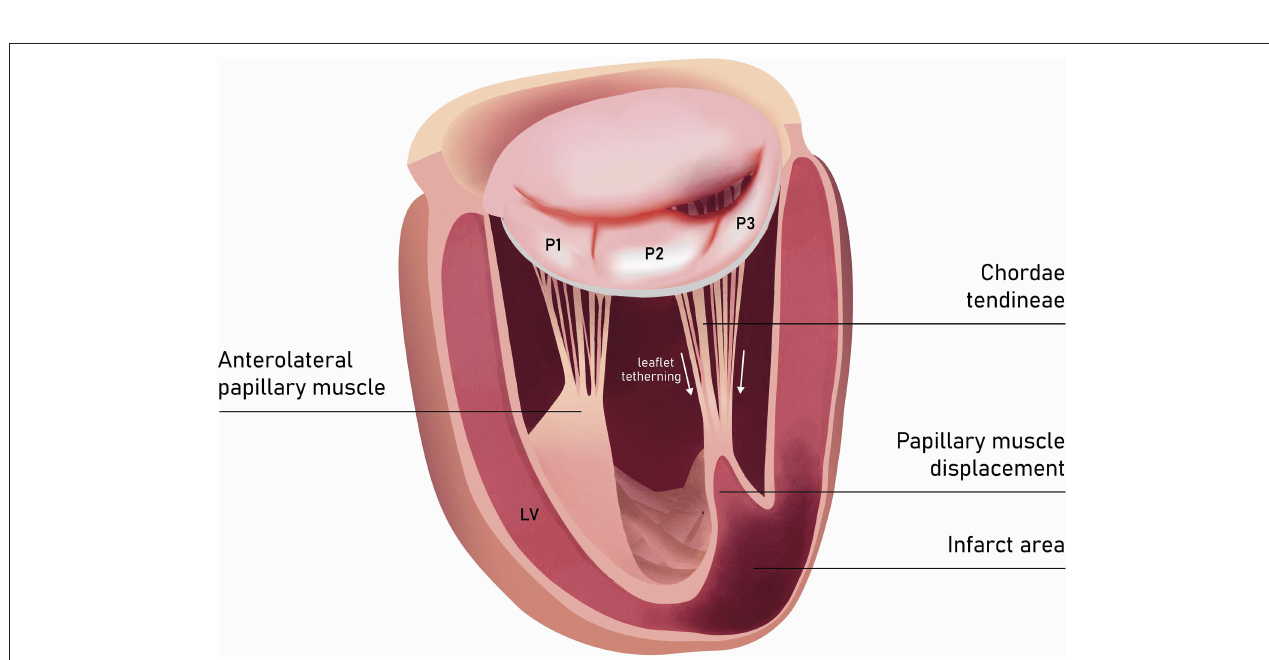
FIGURE 7 | Left ventricle and mitral valve—side view (LVOT was not depicted). The restricted leaflet motion and tethering in the course of posterior papillary muscle ischemia predominantly affects the posteromedial leaflet segment (P3).